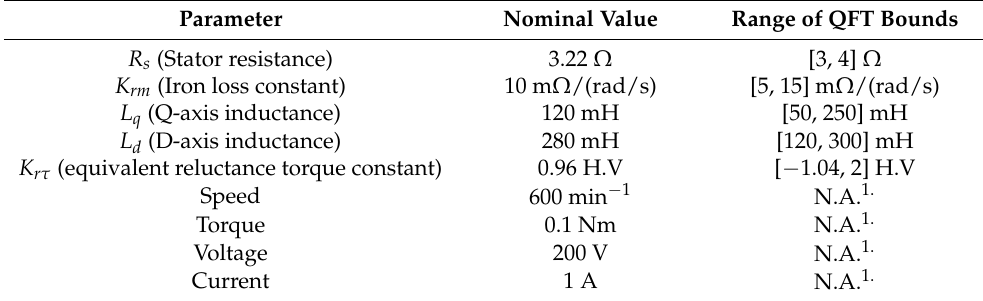
Table 1. SynRM nominal model parameters and their parametric uncertainties. Parameter Nominal Value Range of QFT Bounds R s (Stator resistance) 3.22 Ω [3, 4]